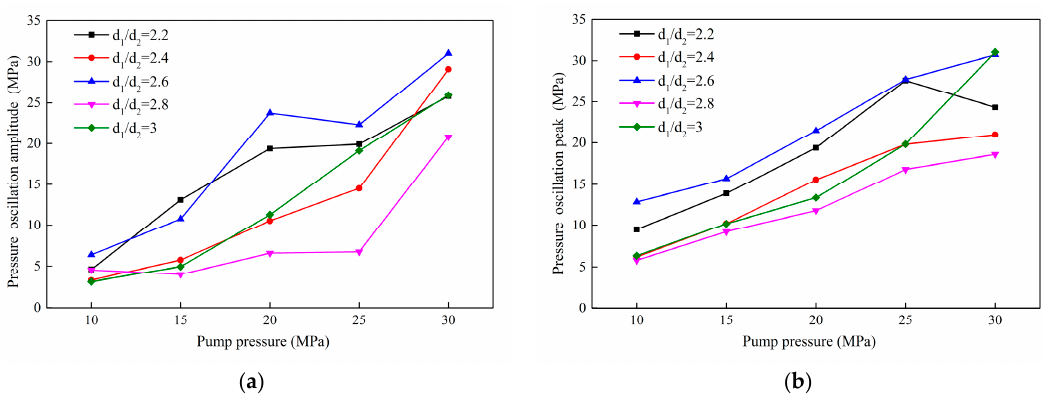
Figure 9. Performance of different d 1 / d 2 nozzles under each pump pressure. ( a ). maximal jet pressure pulsation amplitudes of different d 1 / d 2 nozzles. ( b ). maximal jet peak pressures of different d 1 / d 2 nozzles at each pump pressure.